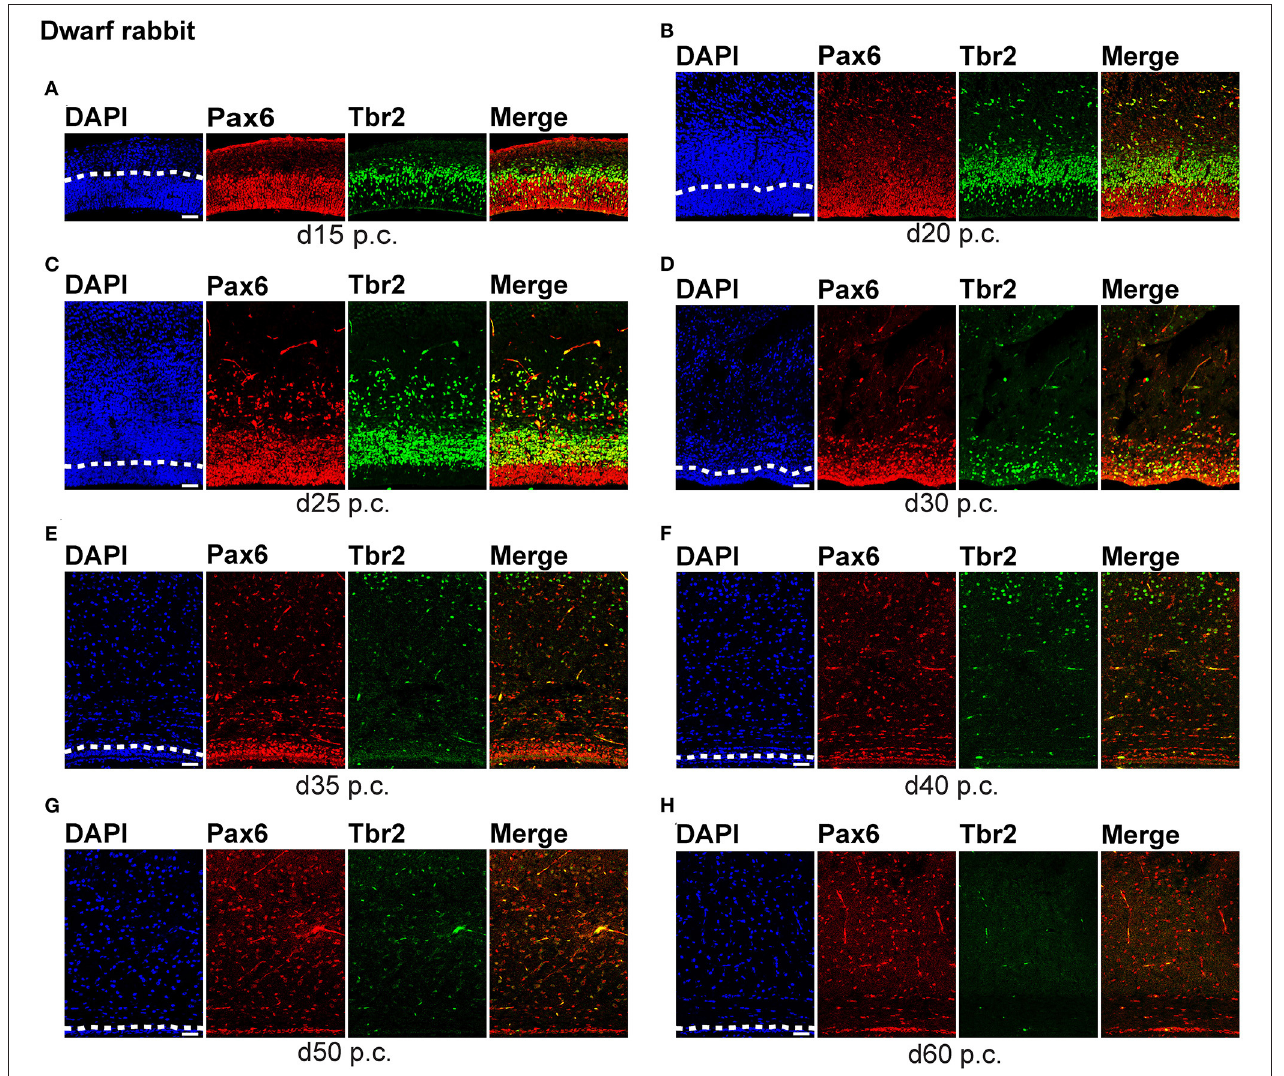
FIGURE 1 | Pax6 and Tbr2 expression in the germinal zones of the developing dwarf rabbit neocortex. (A–H) Double immunofluorescence for Pax6 (red) and Tbr2 (green) and DAPI staining (blue) on 30- µ m cryosections of day 15 to 60 post-conception (p.c.) dwarf rabbit neocortex. The merge images show combined immunofluorescence for Pax6 and Tbr2. (A) The complete cortical wall is shown. (B–H) The top margin of the image corresponds to the transition zone SVZ/intermediate zone (B,C) or the intermediate zone (D–H) . The dashed line indicates the border between VZ and SVZ. Scale bars, 50 µ m. VZ, ventricular zone; SVZ, subventricular